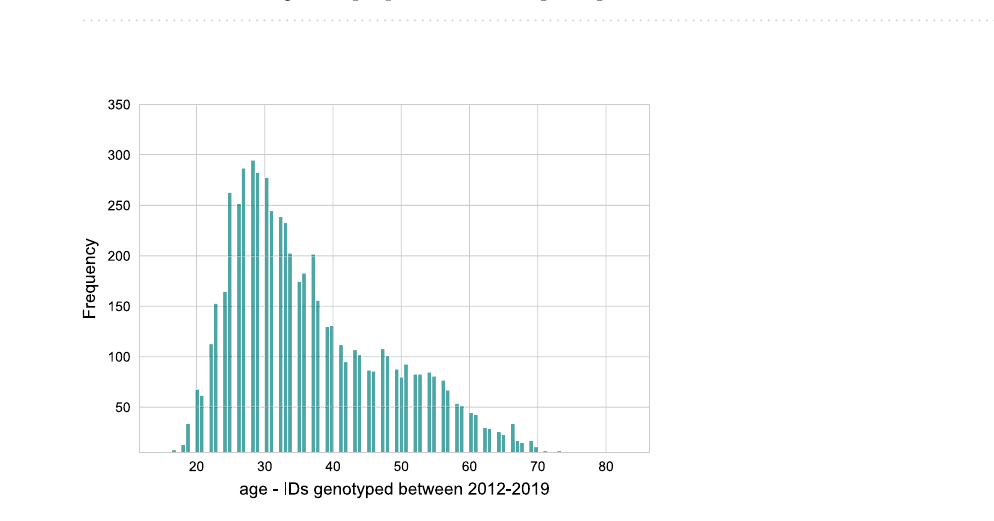
Table 1. Metadata—characteristics of the data and network of Houston/Harris County HIV surveillance data: 2012–2019. 12,818 diagnosed people and 6852 unique sequences.